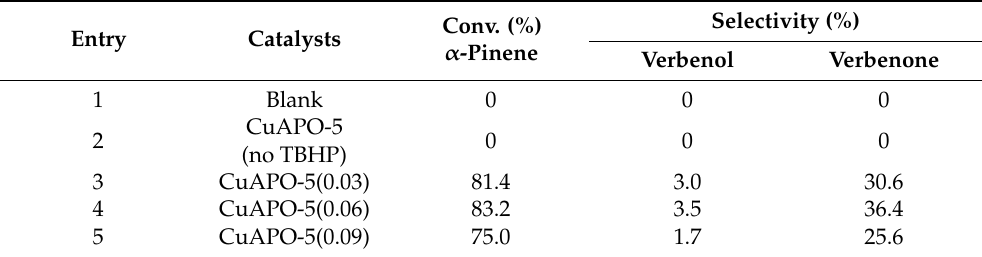
Table 2. Catalytic activity of α -pinene oxidation catalyzed by CuAPO-5 with different copper contents and TBHP-free experiments. Entry Catalysts